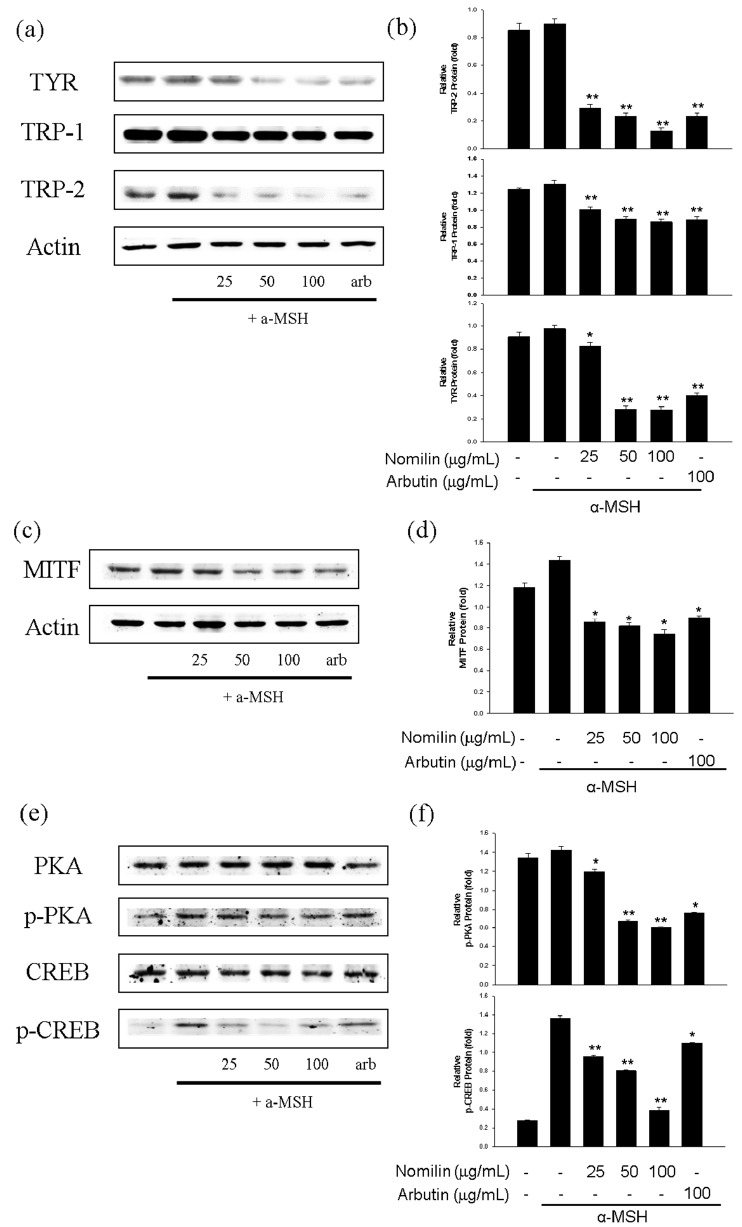
Figure 8. ( a ) Effects of nomilin and arbutin on tyrosinase, TRP-1, and TRP-2 expression in B16F10 melanoma cells. B16F10 cells were treated with different concentrations of nomilin and arbutin prior to α -MSH treatment for 24 h. β -actin was used as a loading control antibody. ( b ) Quantitative analysis of tyrosinase, TRP-1, and TRP-2 by Western blotting. Cell lysates were subjected to Western blotting using antibodies against tyrosinase, TRP-1, and TRP-2. ( c ) Effects of nomilin and arbutin on MITF expression in B16F10 cells. B16F10 cells were treated with the indicated concentrations of nomilin and arbutin prior to α -MSH treatment for 4 h. ( d ) Quantitative analysis of MITF by Western blotting. ( e ) Effects of nomilin and arbutin on p-CREB, CREB, p-PKA, and PKA levels in B16F10 cells. B16F10 cells were treated with the indicated concentrations of nomilin and arbutin prior to α -MSH treatment for 3 h. ( f ) Quantitative analysis of p-CREB, CREB, p-PKA, and PKA by Western blotting. Values are significantly different with Duncan’s multiple range test (significant compared with the vehicle-treated control, * p < 0.05, ** p < 0.01, bars indicate SD). CREB: cAMP response element binding protein, p- CREB: phospho-CREB, α -MSH: α -melanocyte-stimulating hormone, MITF: microphthalmia-associated transcription factor, and PKA: protein kinase A, p-PKA: